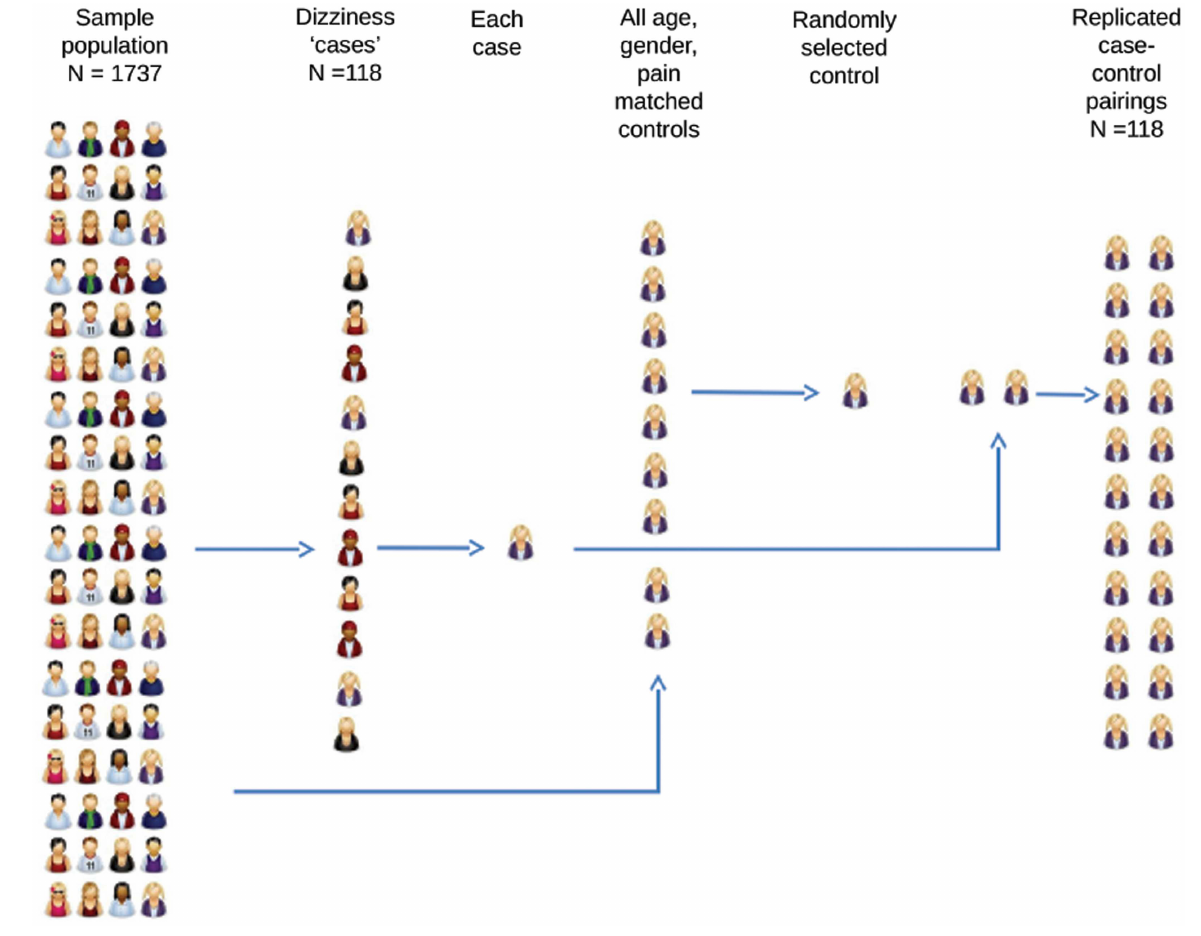
FIGURE 1 | Flow diagram detailing the case-control comparison design . Participants in the sample population who reported dizziness were identified and allocated to the “dizzy” group. Age, gender, and pain-matched controls were randomly selected from the remaining sample